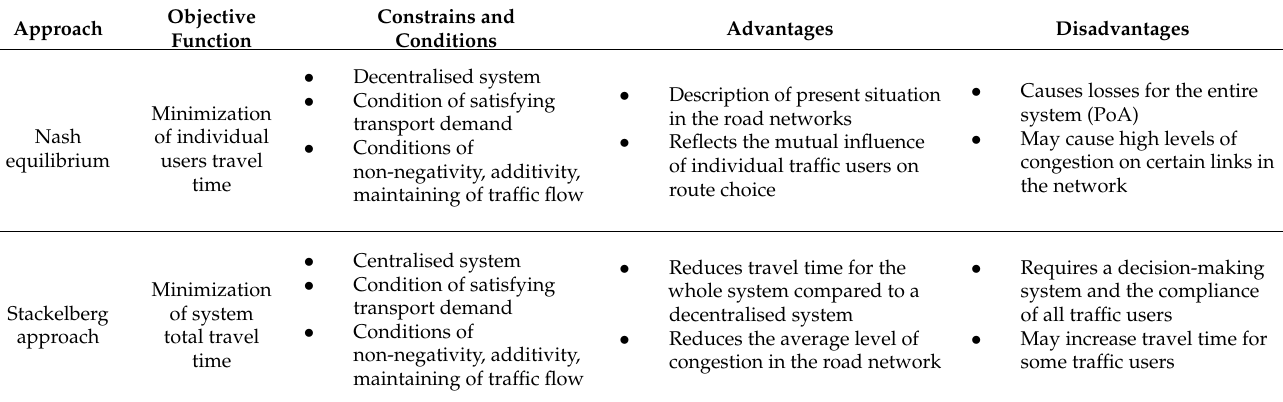
Table 13. Comparison of Nash equilibrium and Stackelberg